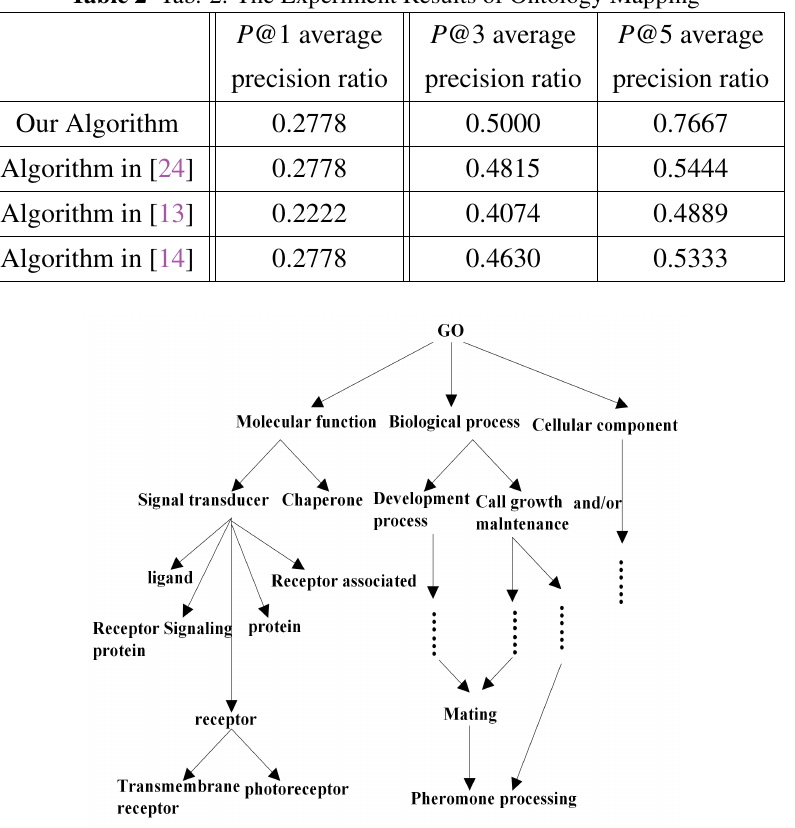
Fig. 4 The Structure of “GO”